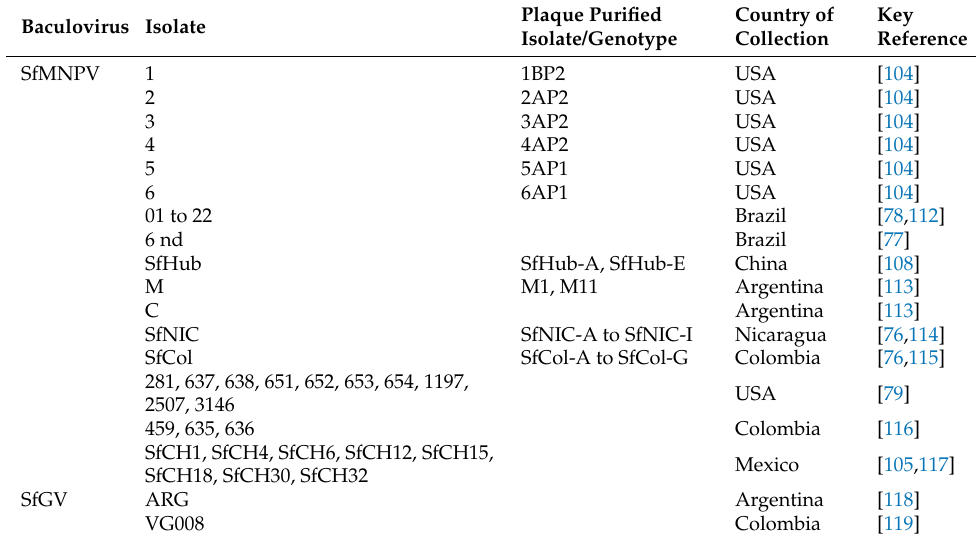
Table 3. Baculoviruses isolated from S. frugiperda